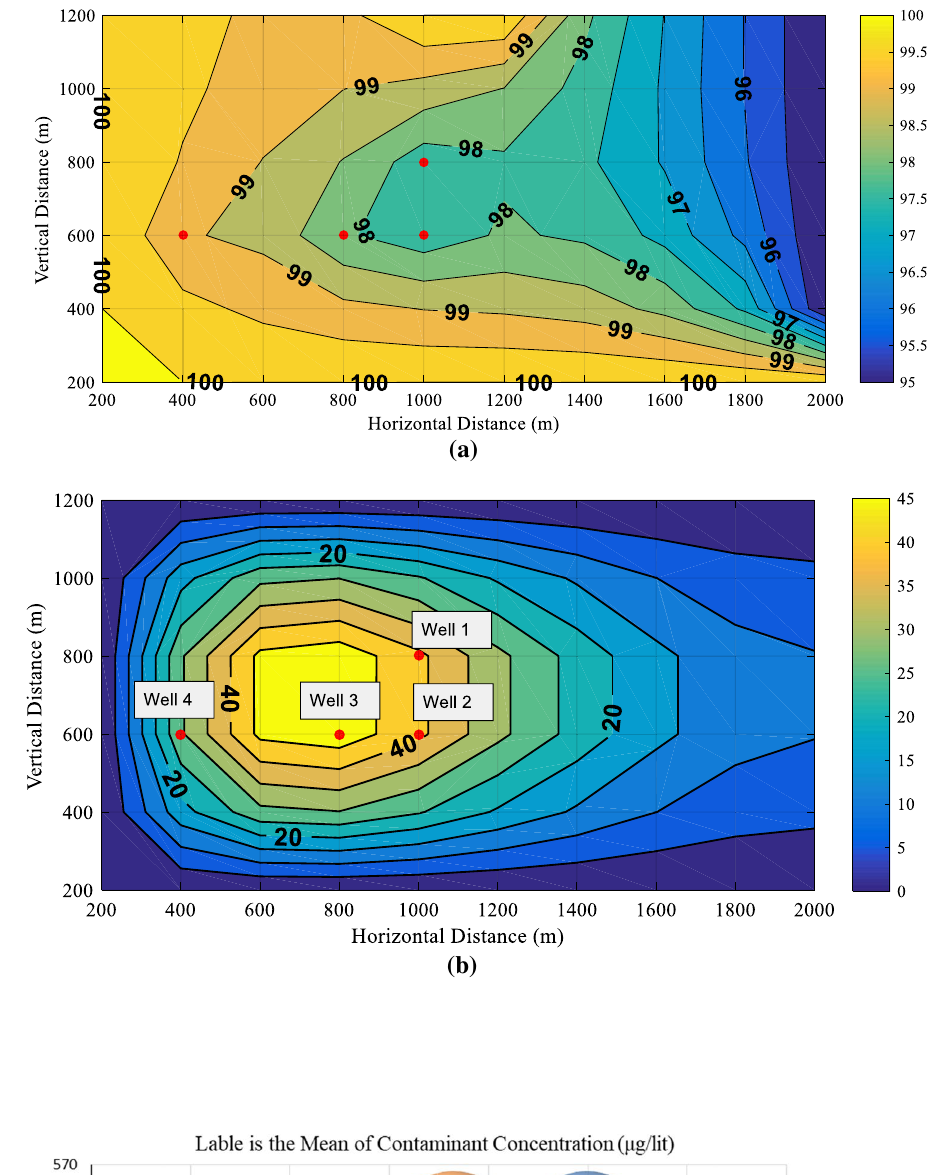
Fig. 10 a Groundwater head, b contaminant concentration